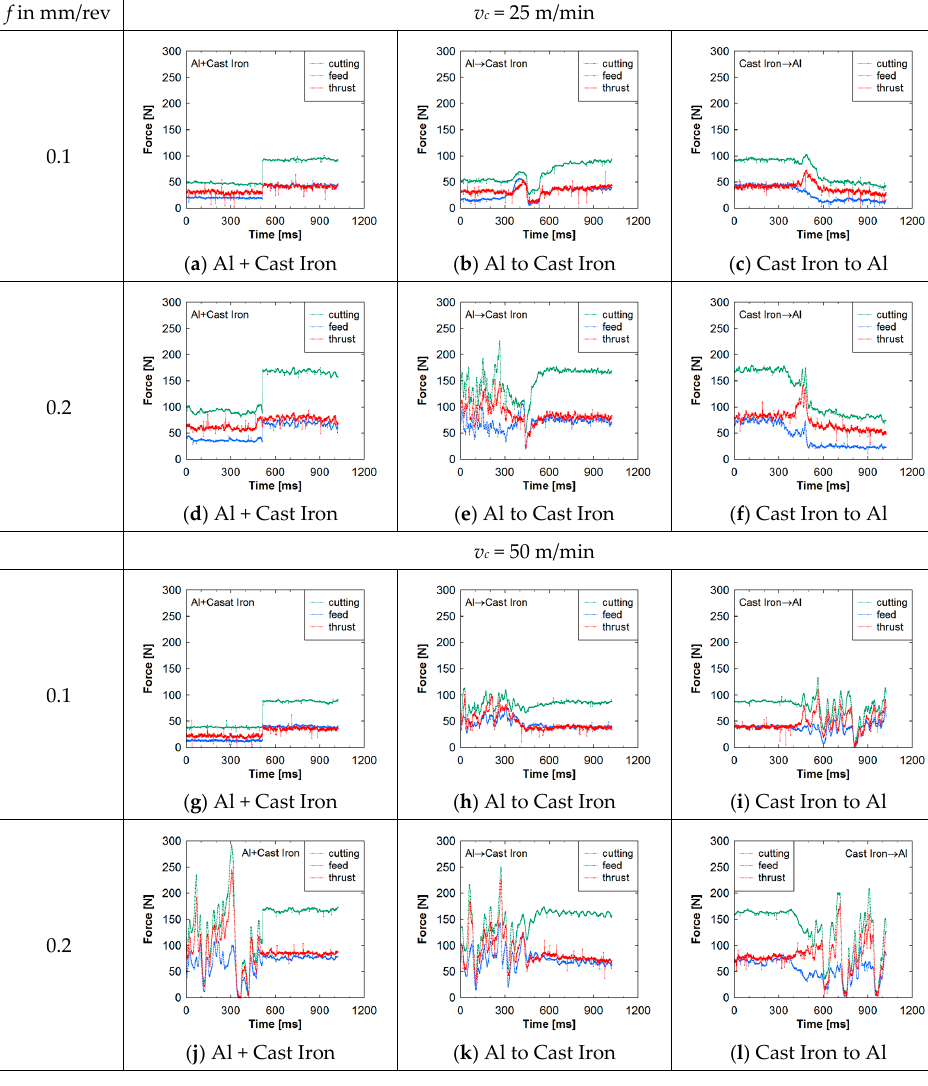
Figure 8. Machining forces underlying Al − CI.